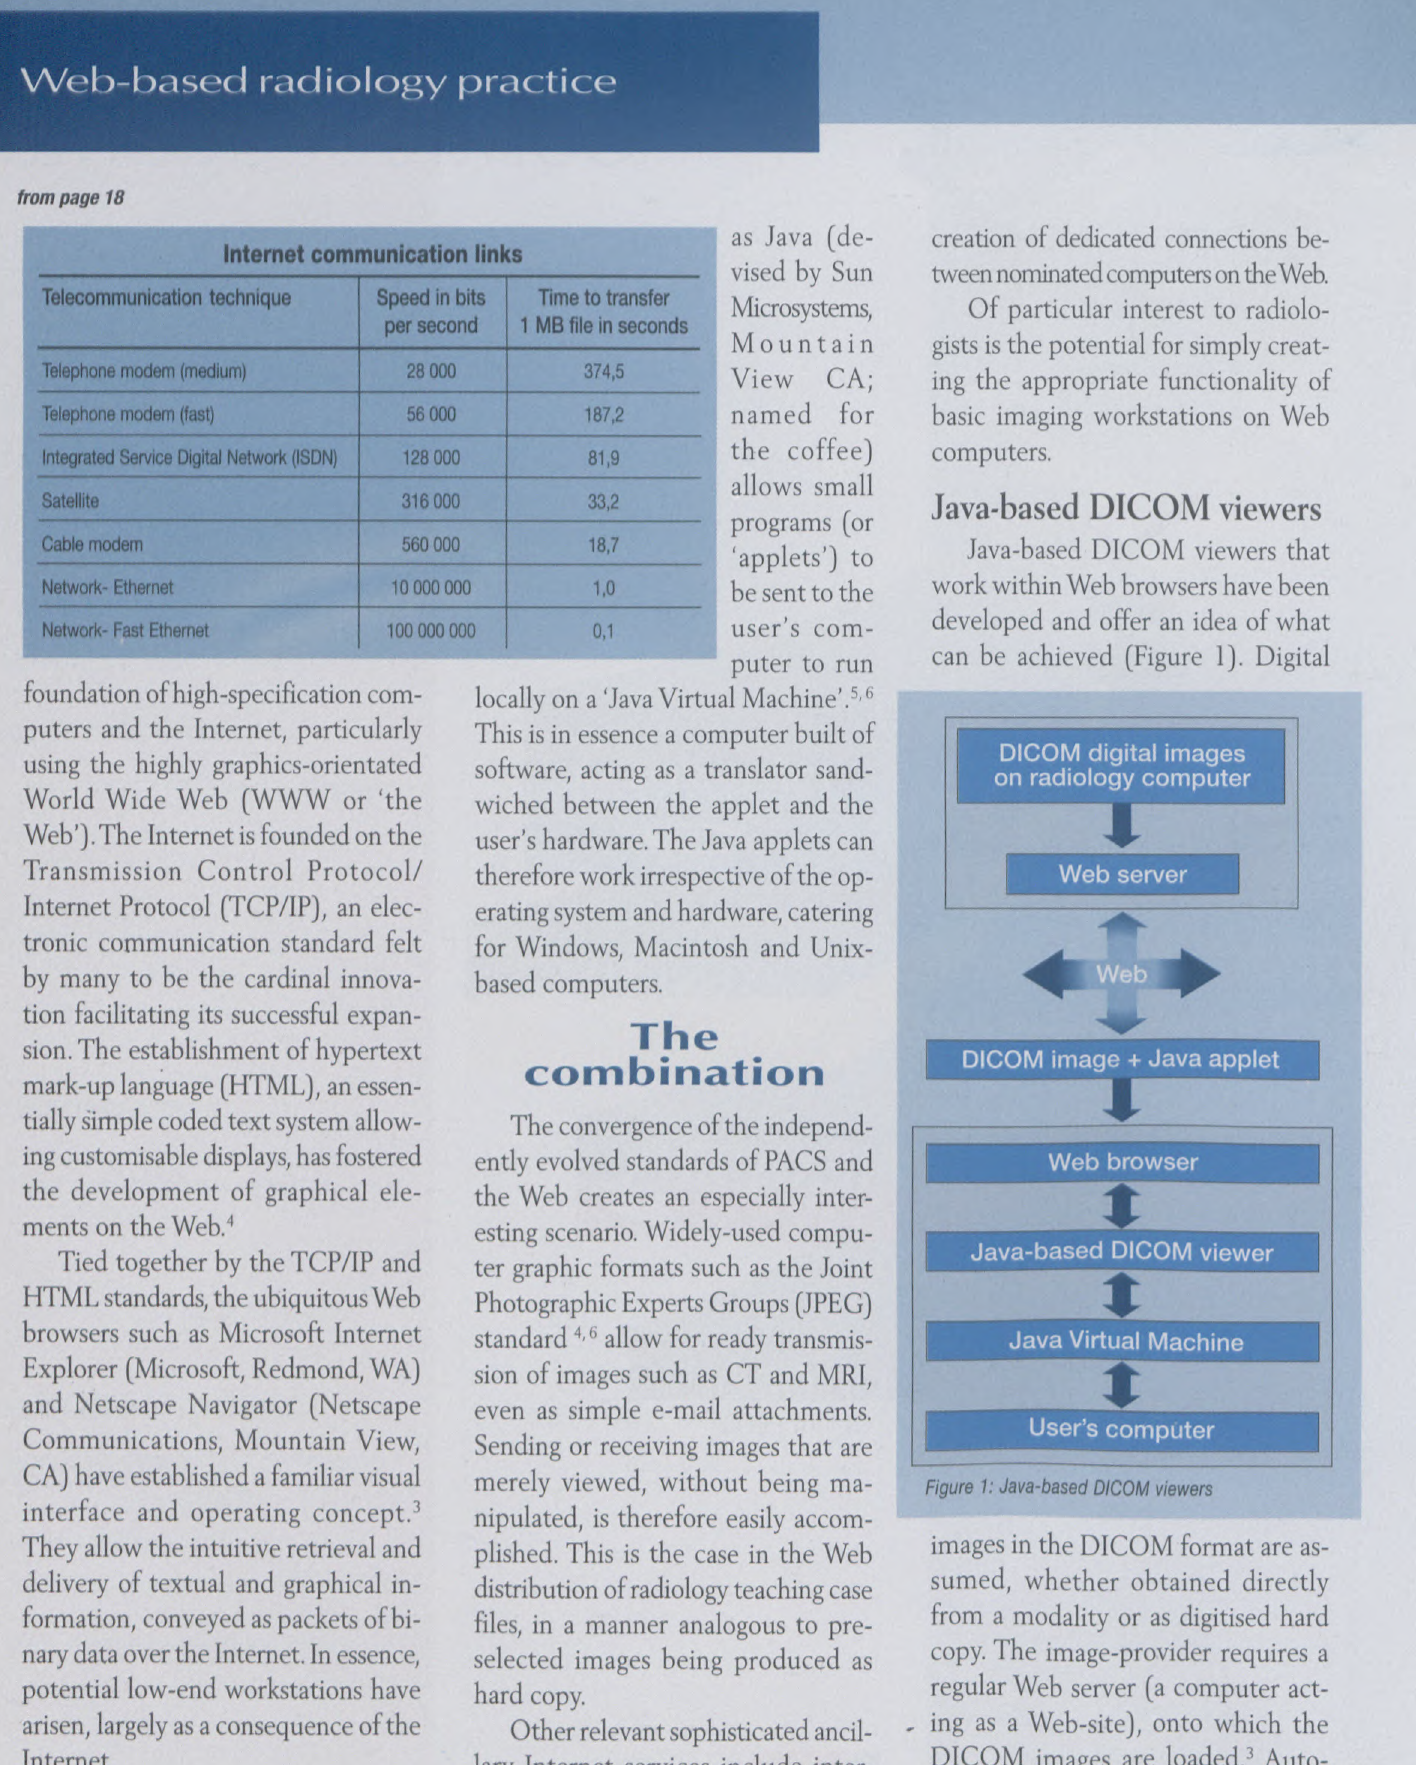
Figure 1: Java-based DICOM